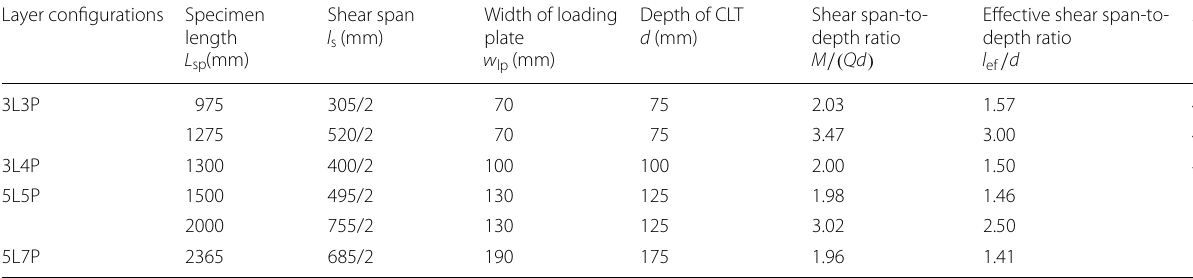
Table 3 Loading conditions for asymmetric four-point bending tests Layer configurations Specimen